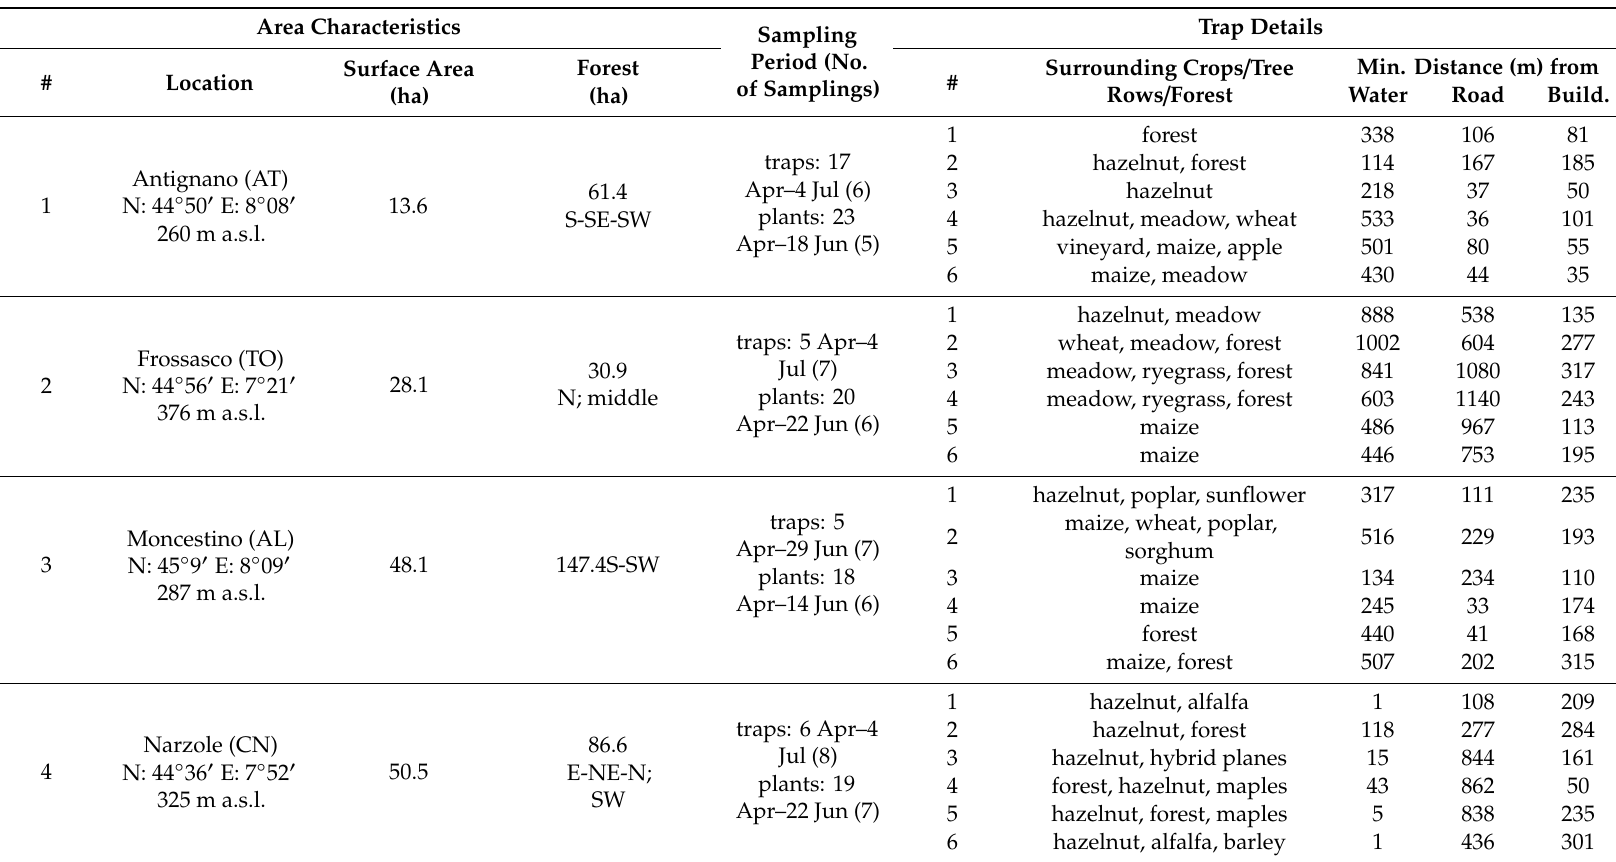
Table 1. Description of the four investigated areas in north-western Italy in 2018, and details on main features of zones enclosing pheromone-baited traps. For each area, the surface area of the adjacent forest together with its position (cardinal points) are